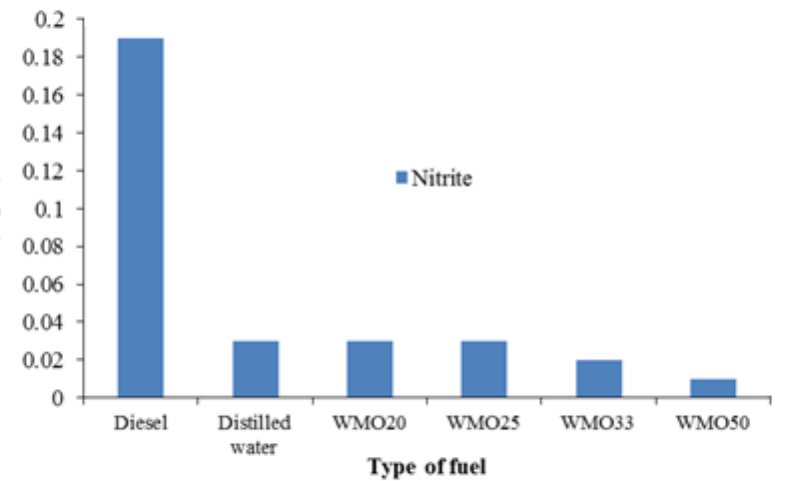
Figure 11. Nitrite content in the rinse for different types of fuel.